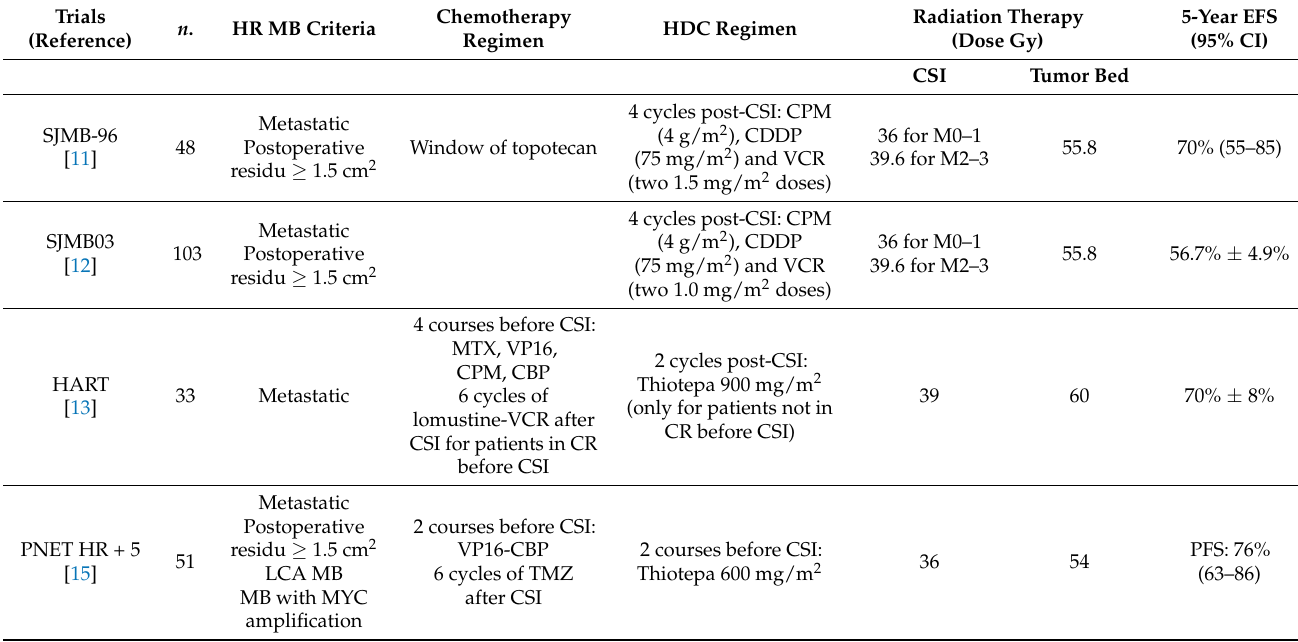
Table 1. High-dose chemotherapy clinical trials for children (>3 years of age) with newly diagnosed HR